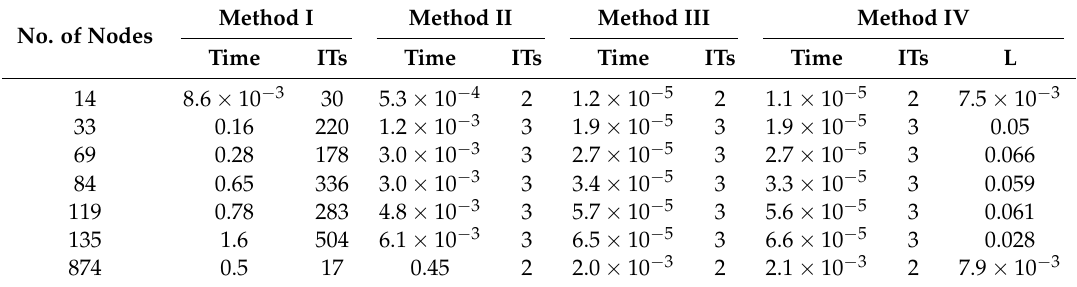
Table 4. Meshed Network